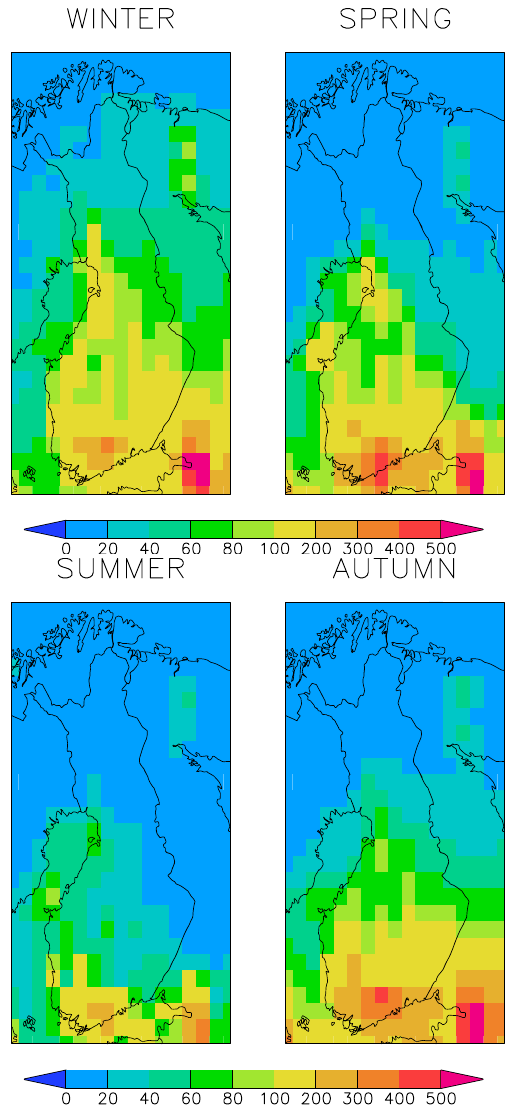
Fig. 18. Modelled seasonal black carbon near-surface median con- centration [ngm − 3 ] over Finland for 2005.